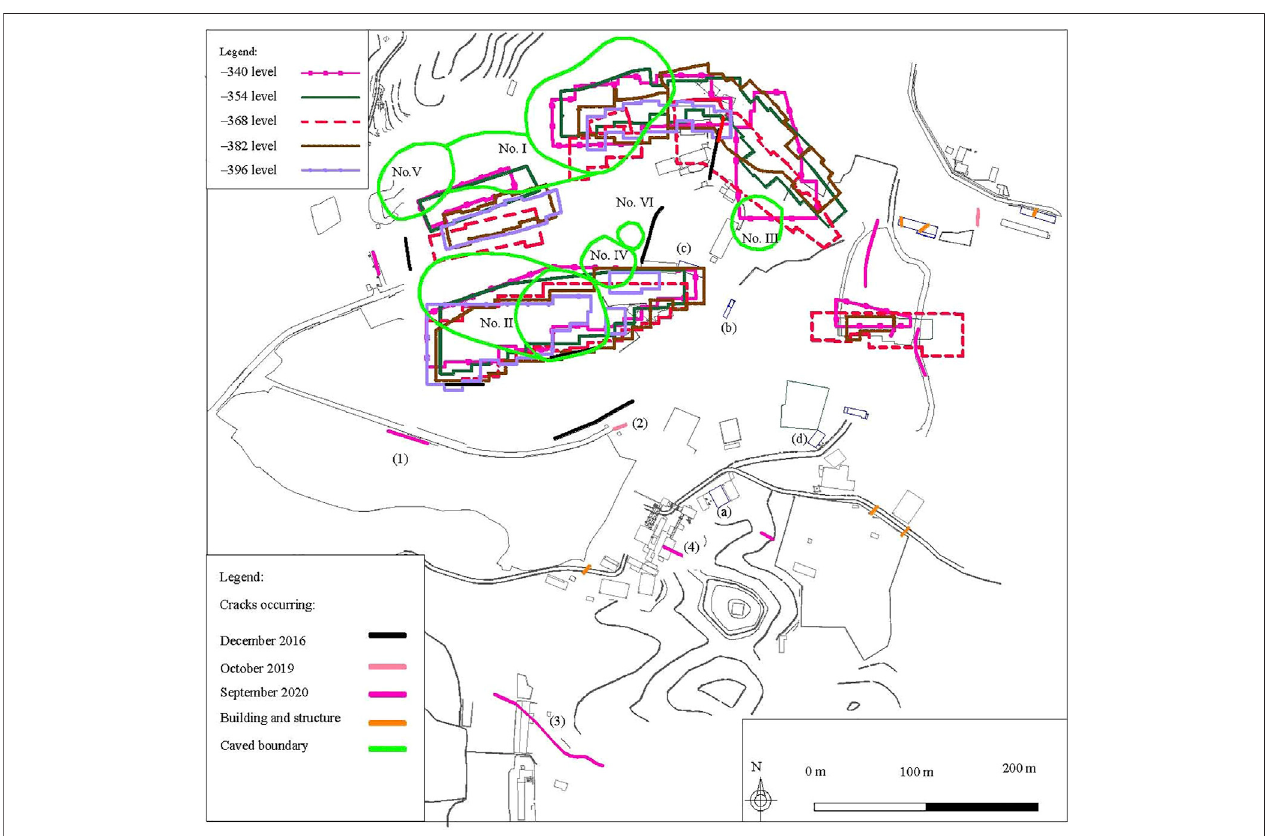
FIGURE 3 | Planar projection of the collapse pits and